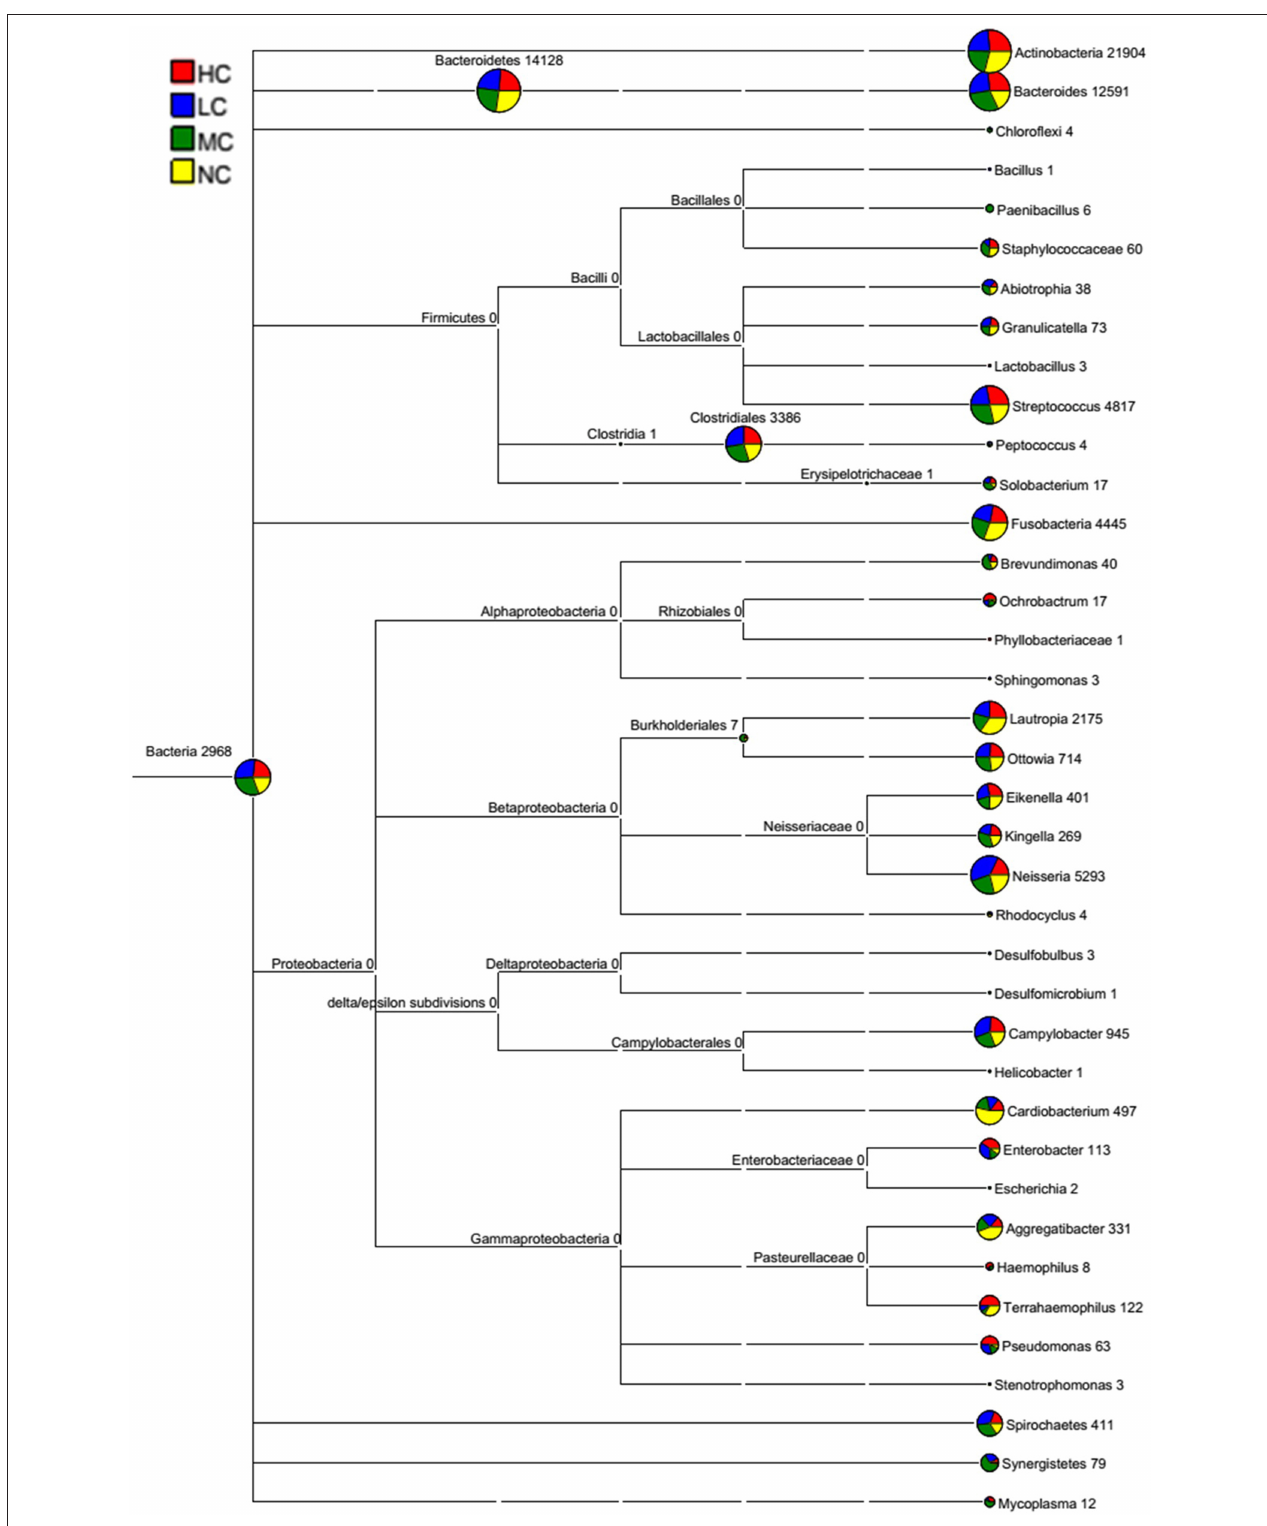
FIGURE 2 | A classification tree showing bacterial abundance by MEGAN. The taxonomy compositions and abundances were visualized by MEGAN (version 4.70.4). The larger the area of the colored pie chart, the greater the bacterial abundance. Different colors represent different groups, and the larger the colored sectorial area at a branch, the more the corresponding group contributed to the bacterial abundance.